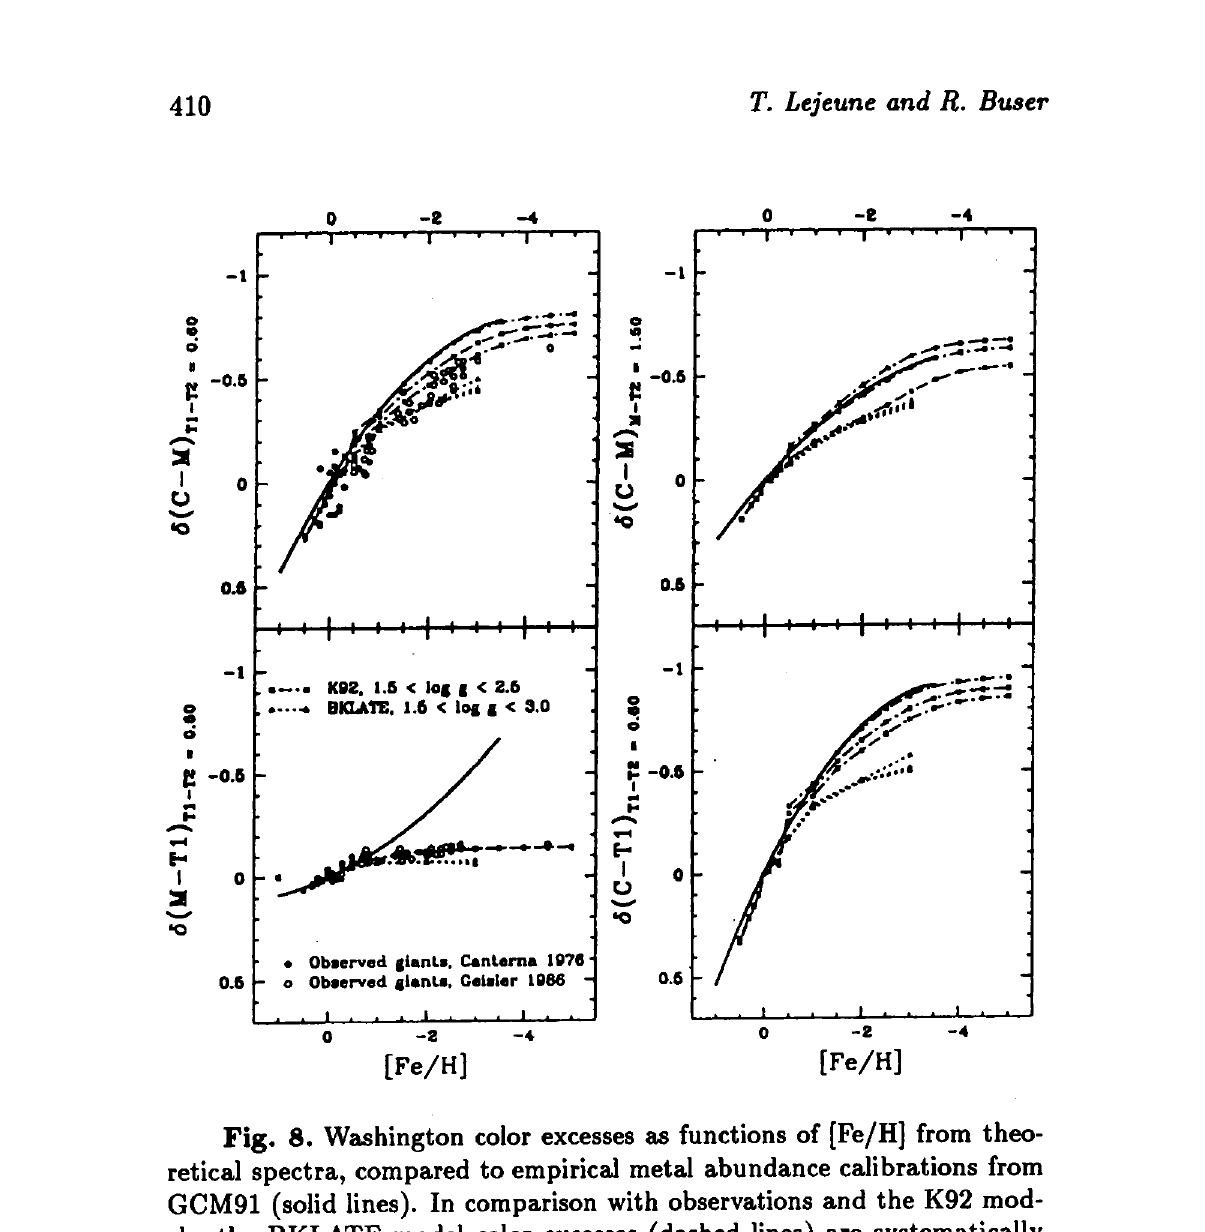
Fig. 8. Washington color excesses as functions of [Fe/H] from theo- retical spectra, compared to empirical metal abundance calibrations from GCM91 (solid lines). In comparison with observations and the K92 mod- els, the BKLATE model color excesses (dashed lines) are systematically too small with increasing metallicity (see the